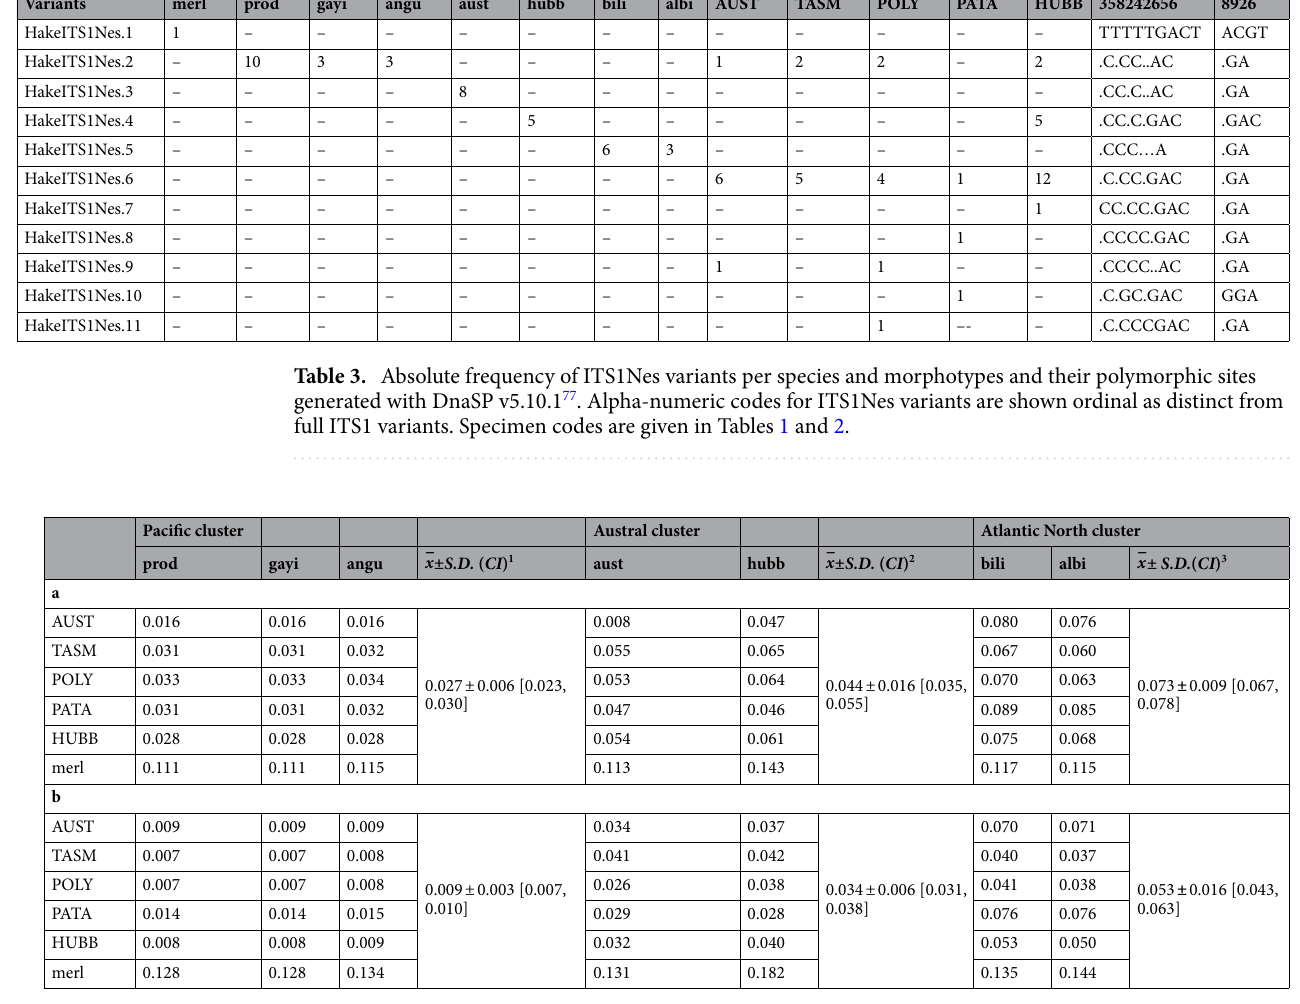
haplotypes (Fig. 1b). The Bayesian phylogenetic reconstruction from MRBAYES on cyt b haplotypes recovered a strong supercluster split and a polytomy within the New World supercluster to which M. bilinearis was ancestor (Supp. Figure S3b). The Bayesian phylogenetic reconstruction of BEAST on cyt b haplotypes recovered a well- supported both, supercluster split and cladogenesis within superclusters, where M. bilinearis was basal to New World hakes (Fig. 1b).